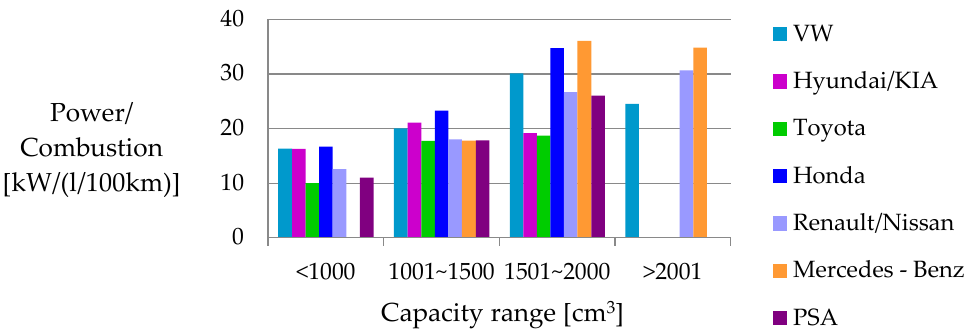
Figure 9. The ratio of maximum power to combustion in the individual engine capacity compartments; European and Asian car brands. Source: Developed own.